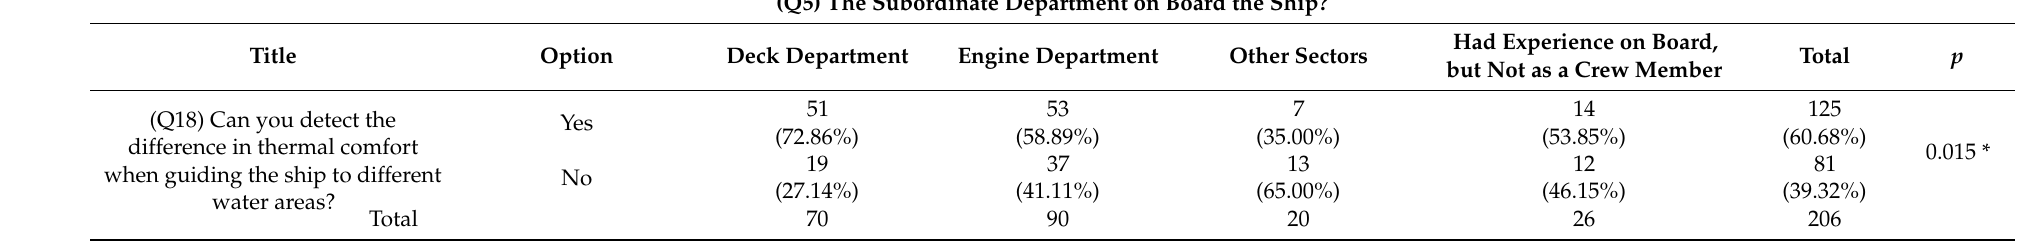
Table 5. Questionnaire for departments and thermal